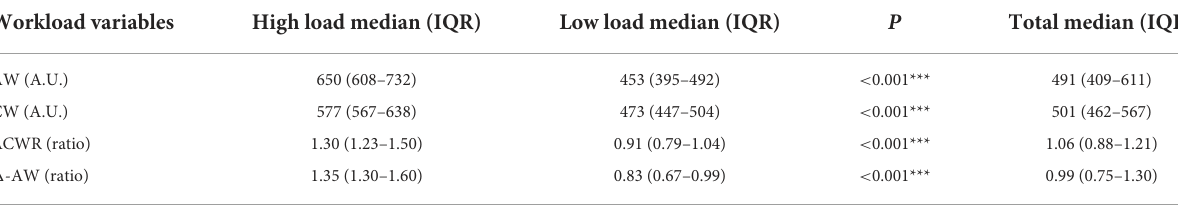
TABLE 1 Descriptive information of workload parameters based on high- and- low- level load. Workload variables